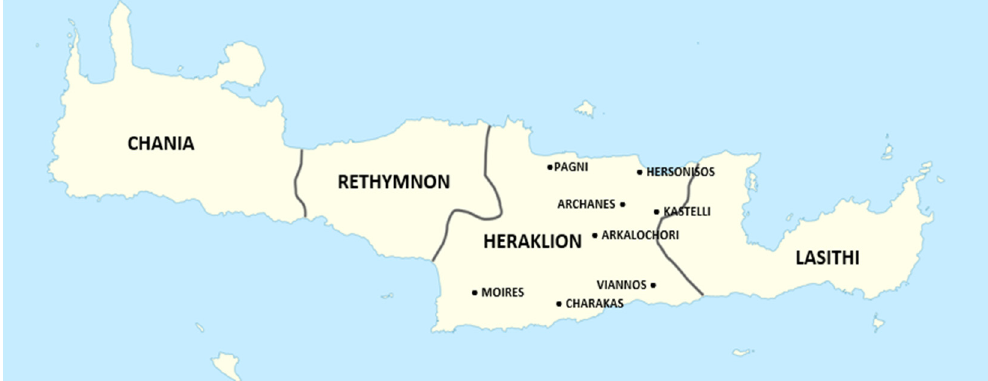
Figure 1. Catchment area of MMHU in Heraklion.